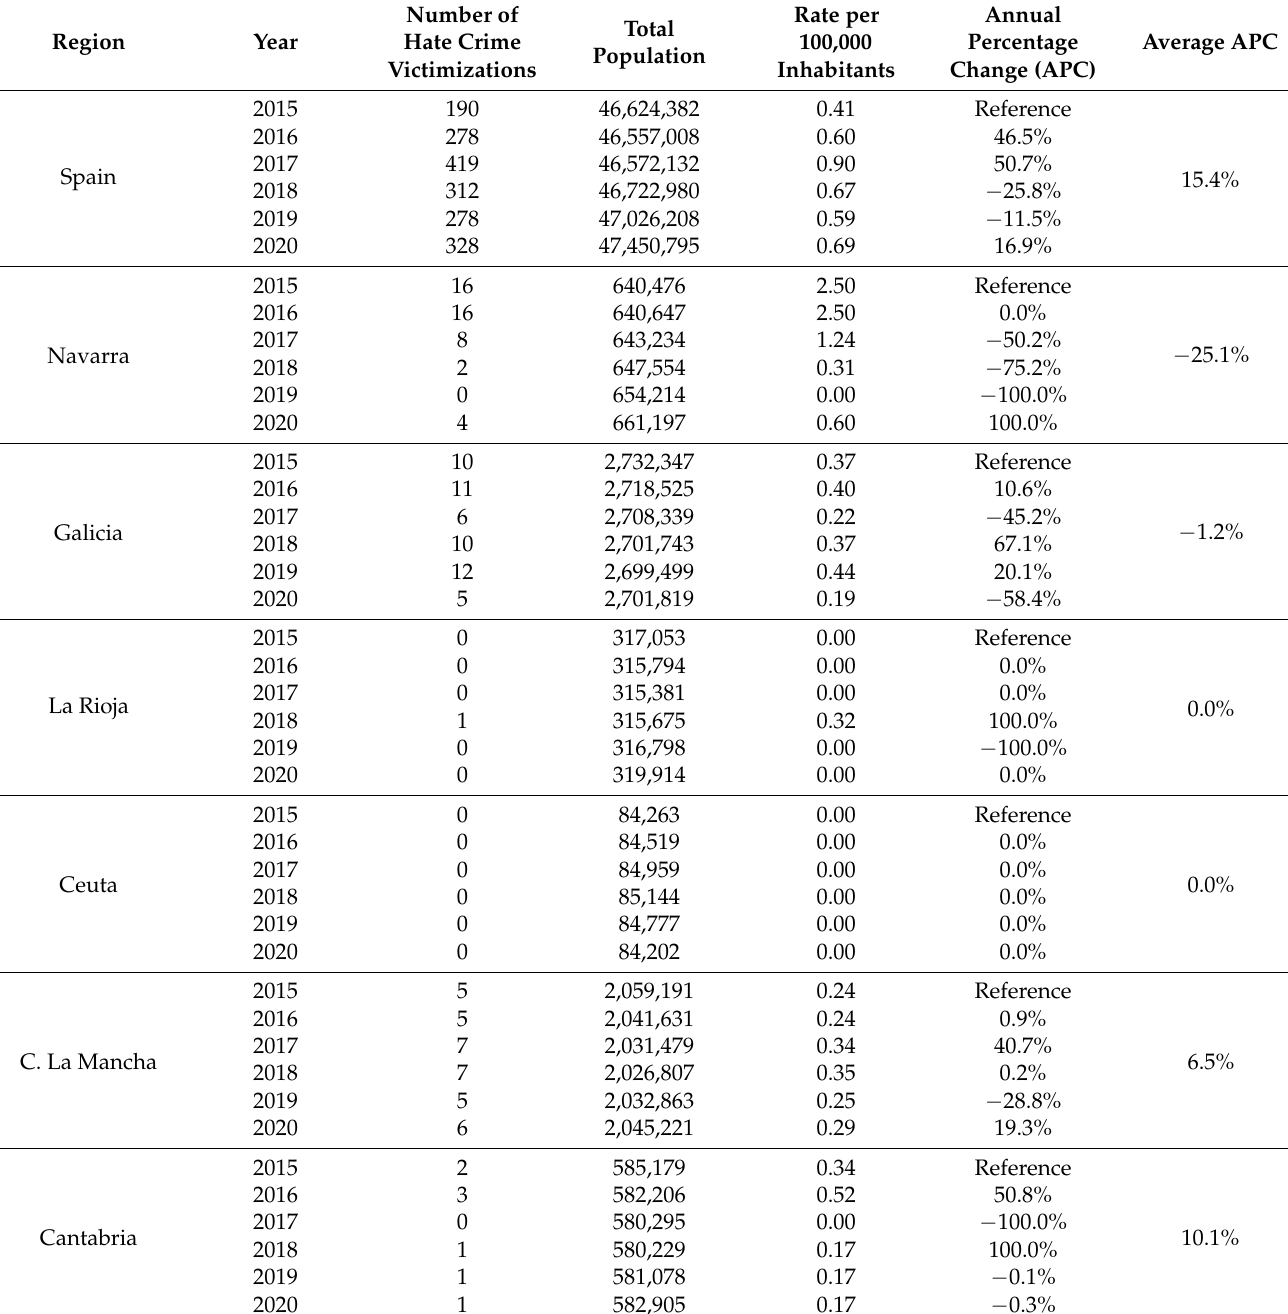
Table 1. Hate crimes based on sexual identity or orientation at the national level and in each autonomous community: number, population, rates per 100,000 inhabitants and average annual percentage of change (Spain,